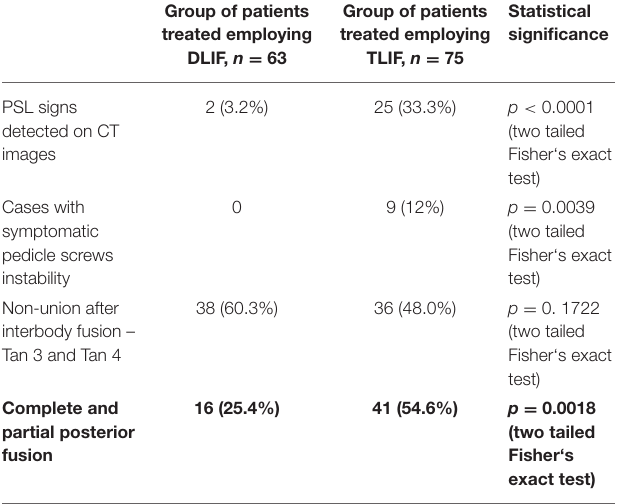
TABLE 2 | The initial analysis of the results.